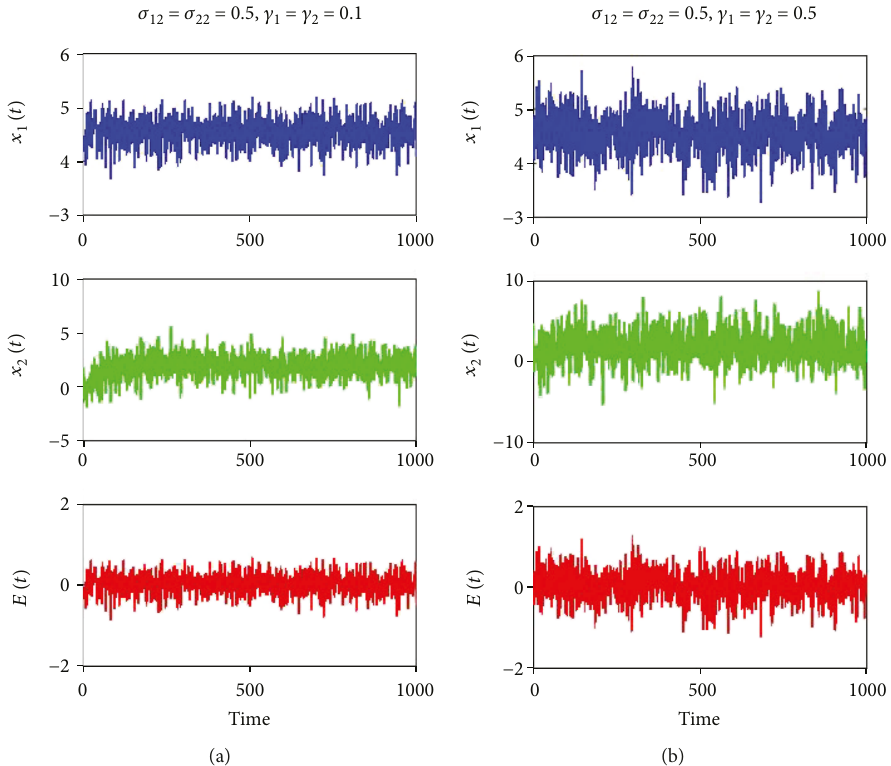
= 2 , b = 0 4 , a = 0 5 , k = 6 , q = 0 1 , m 1 1 1